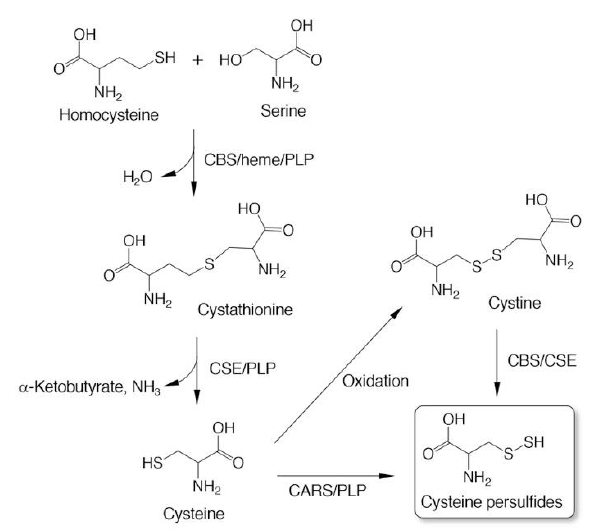
Figure 2. Enzymatic production of cysteine persulfides (CysSSHs). CBS, cystathionine β -synthase; CSE, cystathionine γ-lyase; CARS, cysteinyl-tRNA synthetase. Cofactors heme and pyridoxal phosphate (PLP) are also indicated.